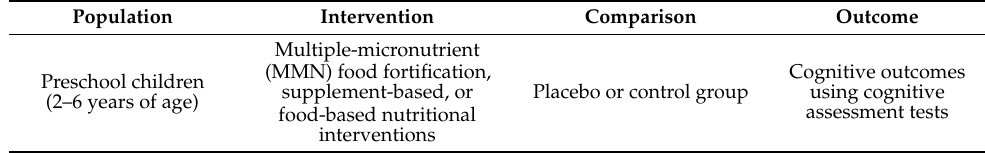
Table A1. PICO framework: keywords.